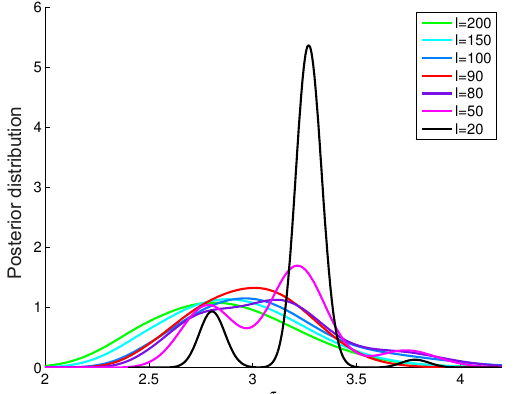
Fig. 4. The effect of correlation length l , defining the model er- ror covariance matrix, on the posterior probability distribution. The posterior is the weighted average on individual posteriors, each fit- ted with the same model discrepancy term. Each coloured curve corresponds to the averaged posterior obtained with a given value of the correlation length.